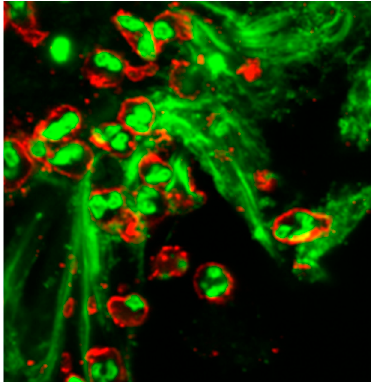
Figure 4. After stimulation with S. epidermidis biofilms, neutrophils also release DNA (stained in green), as shown by laser scan microscopy.